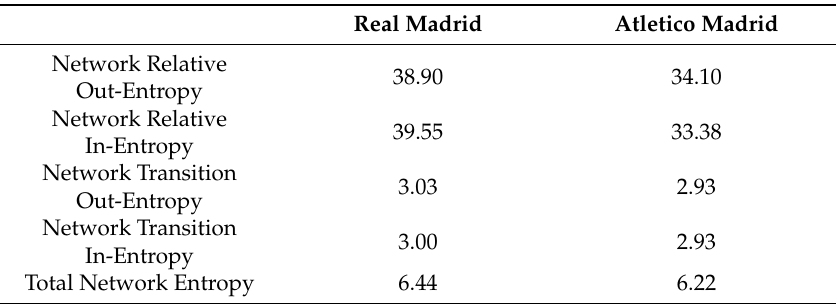
Table 1. Team entropy